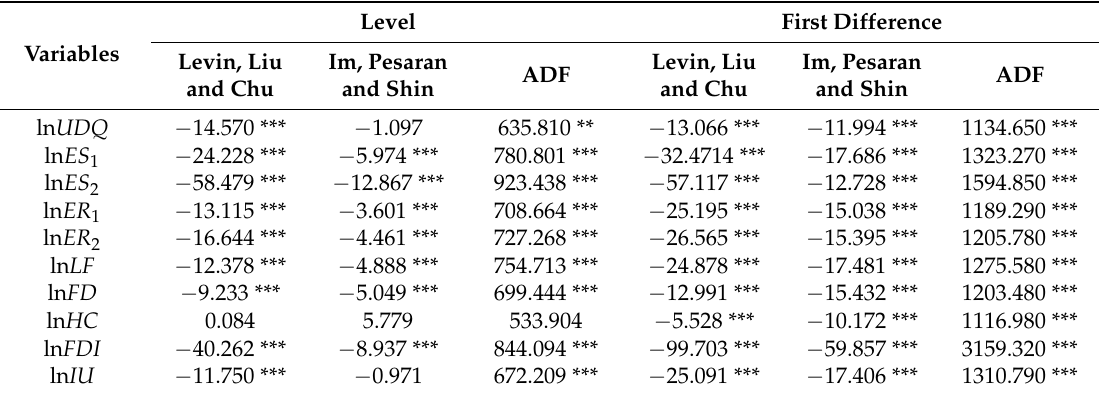
Table 3. Panel unit root test